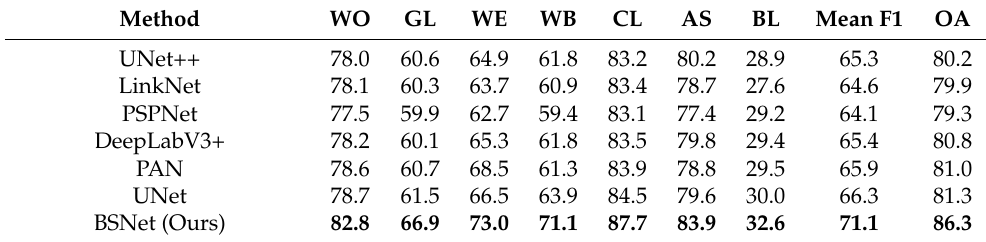
Table 3. Accuracy comparison between our BSNet and other methods on the Landsat core dataset.